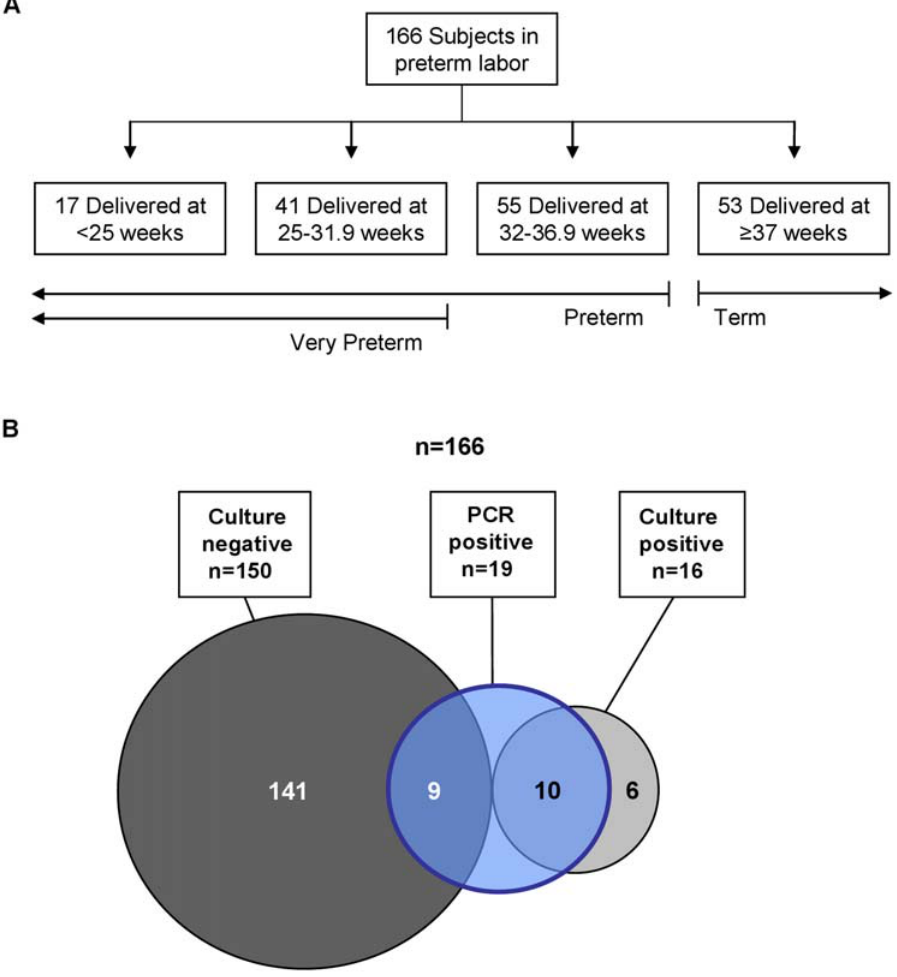
Figure 1. Gestational Outcomes and Amniotic Fluid Findings. Panel A shows outcomes of enrolled subjects. Panel B summarizes results of culture and PCR analysis of amniotic fluid. PCR refers to end-point PCR for bacteria, fungi and archaea. Culture refers to the use of routine cultivation methods for bacteria (aerobic, anaerobic and genital mycoplasmas) and fungi. Circle areas are not to scale.